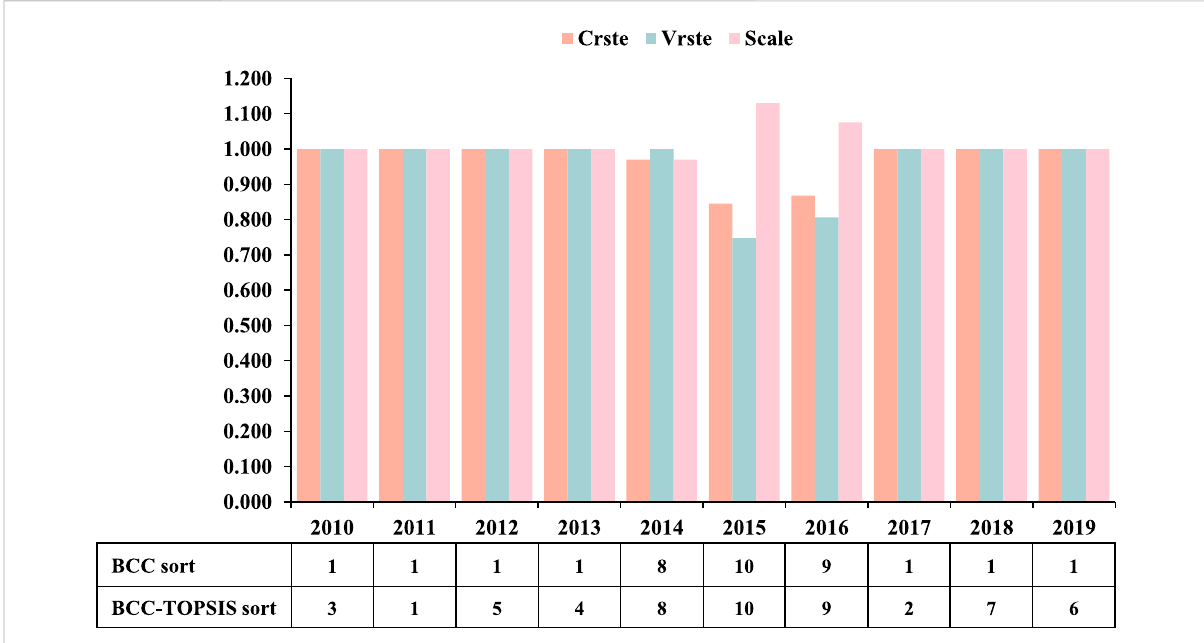
FIGURE 5 Evaluation results of the ef fi ciency of EDF ’ s investment and merger in the fi eld of energy